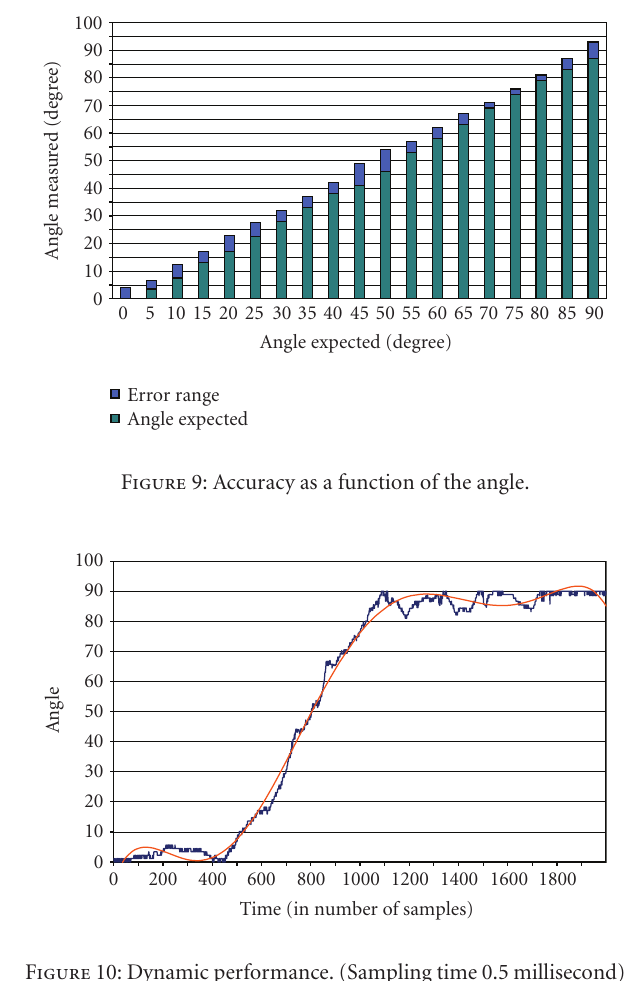
Figure 10: Dynamic performance. (Sampling time 0.5 millisecond)